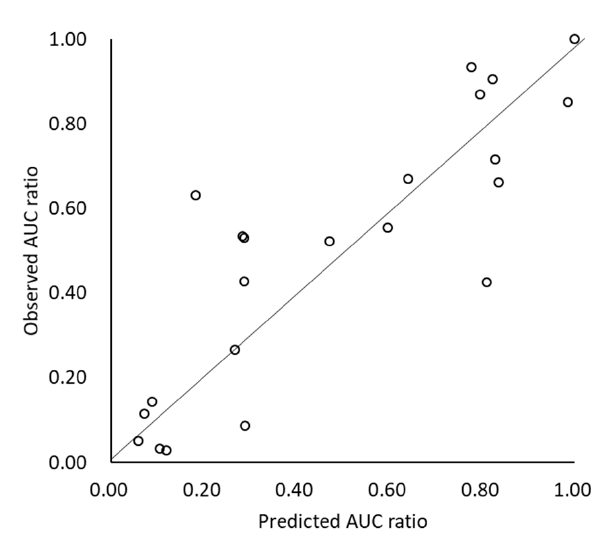
Figure 2. Predicted and observed AUCr with/without ARA.